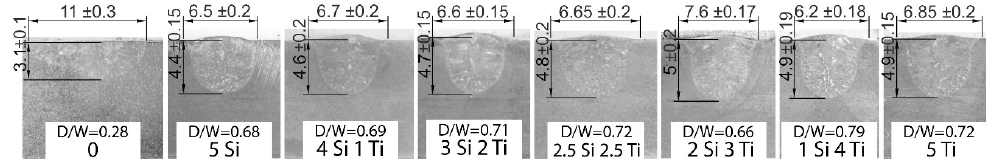
Figure 2. Macro images of specimens welded without (specimen 0) and with coating (specimens 5Si, 4Si1Ti, 3Si2Ti, 2.5Si2.5Ti, 2Si3Ti, 1Si4Ti, and 5Ti), with the indicated weld bead widths, penetration depth/width ratios (D/W ) , and standard deviations.